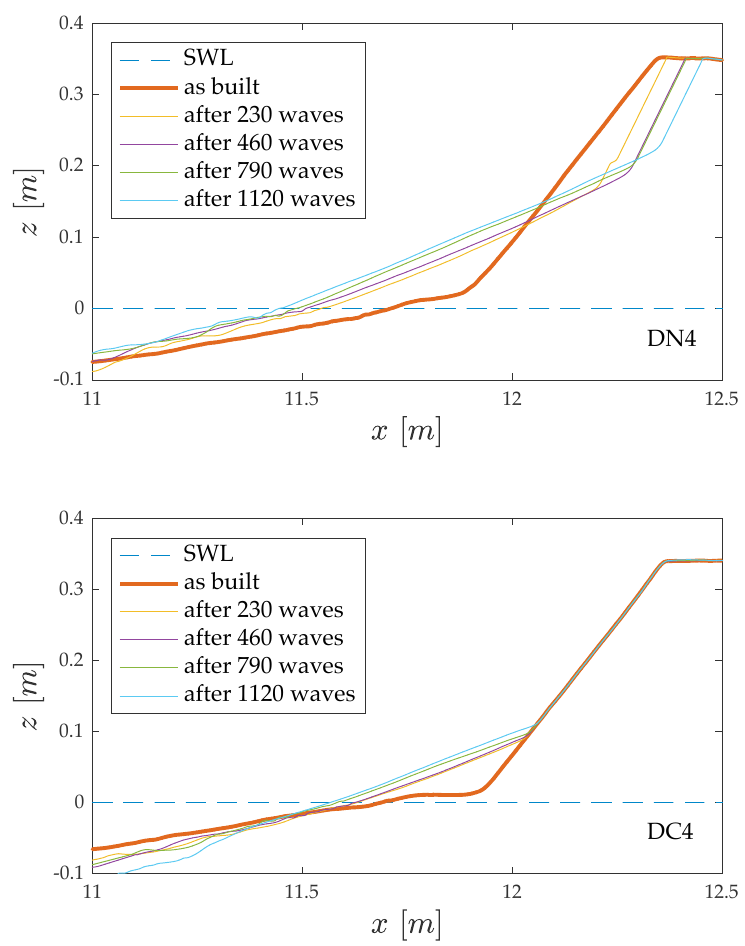
Figure 10. Measured cross-shore profiles after 230, 460, 790, and 1120 waves for tests DN4 ( up ) and DC4 ( down